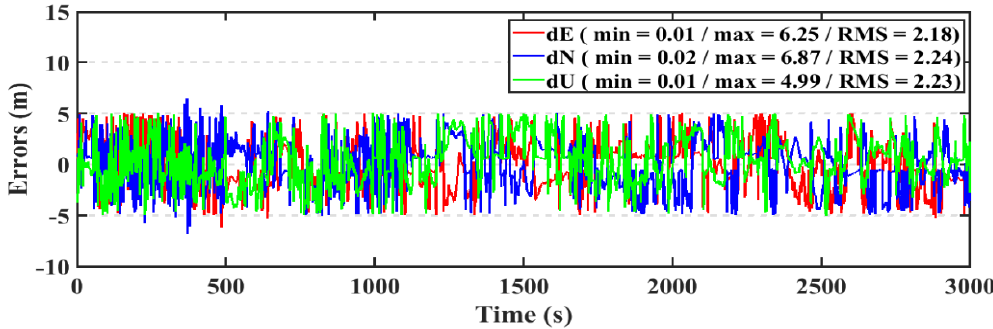
Figure 25. Position errors for the RT-PPP solution (kinematic/second dataset).